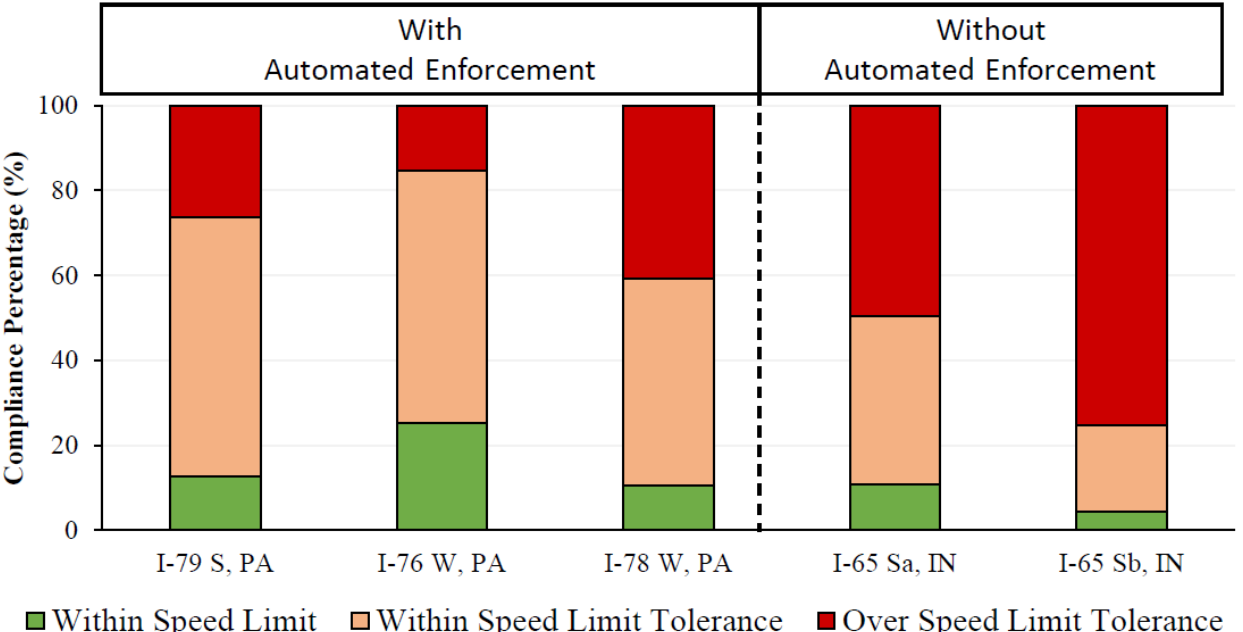
Figure 10. Speed compliance comparison for work zones with and without enforcement.